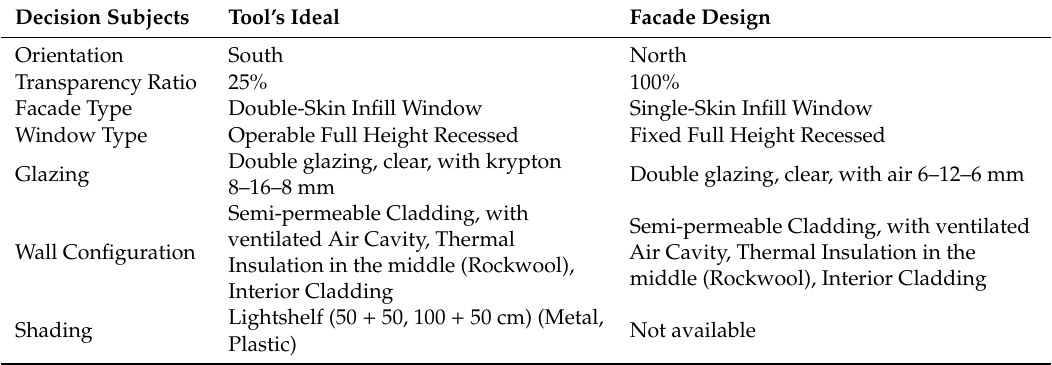
Table 5. Comparison of design decisions for Antalya.